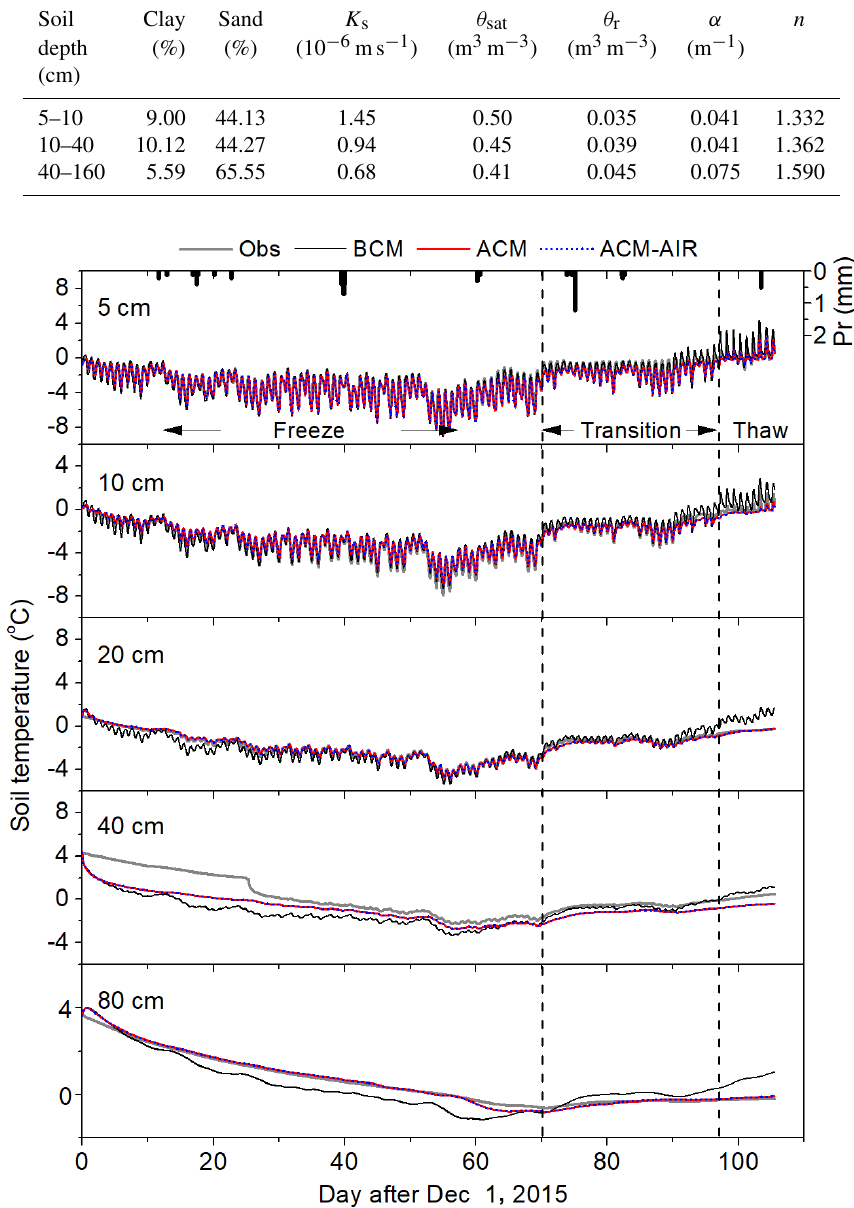
Figure 2. Comparison of measured (Obs) and estimated time series of soil temperature at various soil layers using the basic coupled model (BCM), advanced coupled model (ACM), and advanced coupled model with airflow